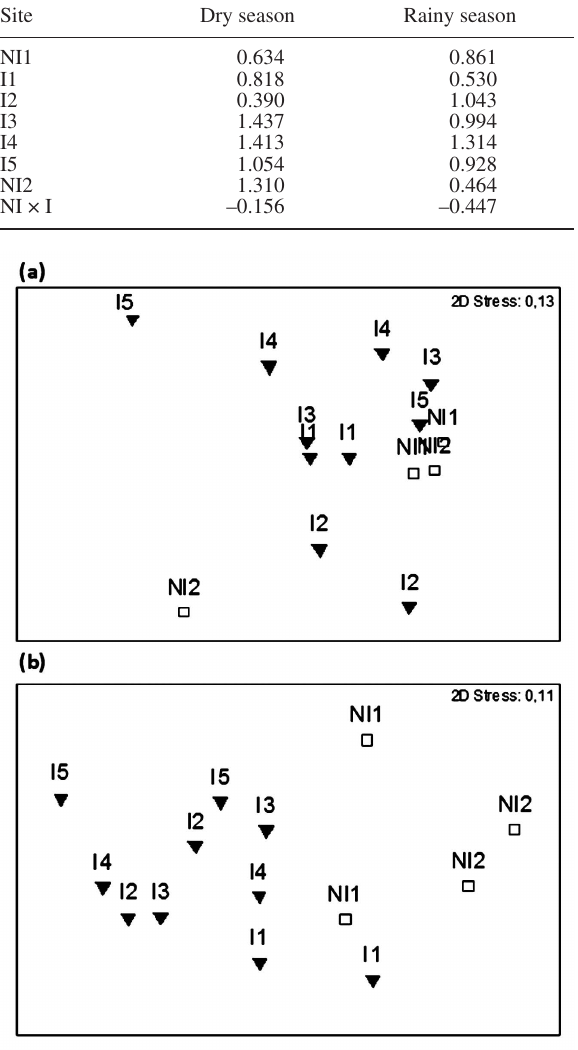
Fig . 5. – MDS plots of benthic community data performed with Bray-Curtis similarities. Abundance data were fourth-root trans- formed. (a) Dry season; (b) Rainy season. I, impacted sites; NI, non-impacted sites.